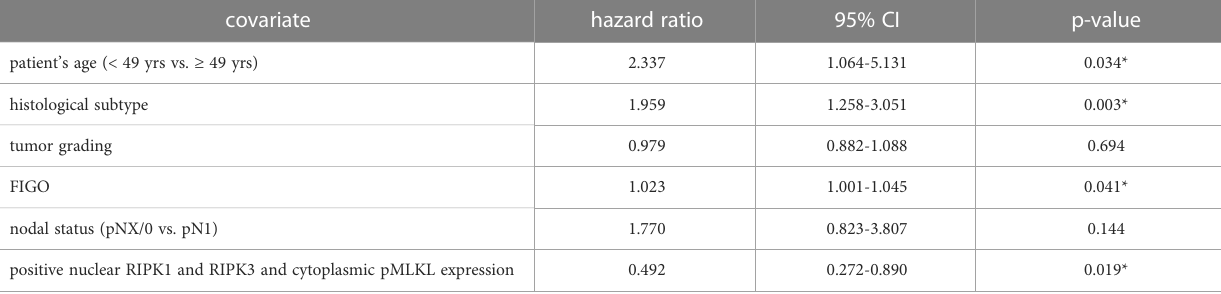
TABLE 9 Multivariate Cox regression analysis of cervical cancer patients ( n = 250) and their clinical and pathological characteristics including nuclear RIPK1-RIPK3 and cytoplasmic pMLKL co-expression regarding